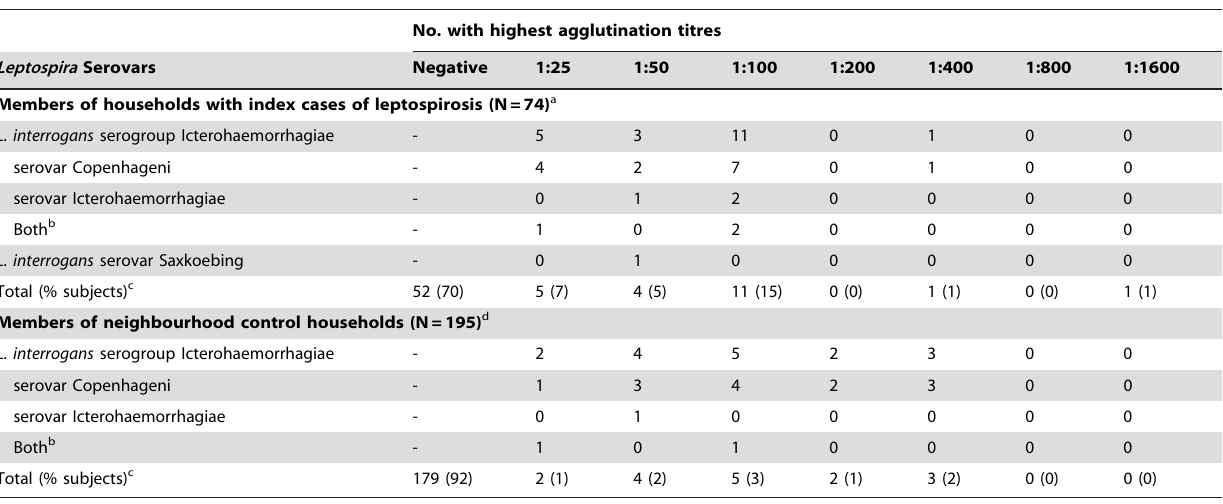
Table 1. Distribution of microscopic agglutination titres for members of households with an index case of severe leptospirosis and neighbourhood control households from slum communities in Salvador,